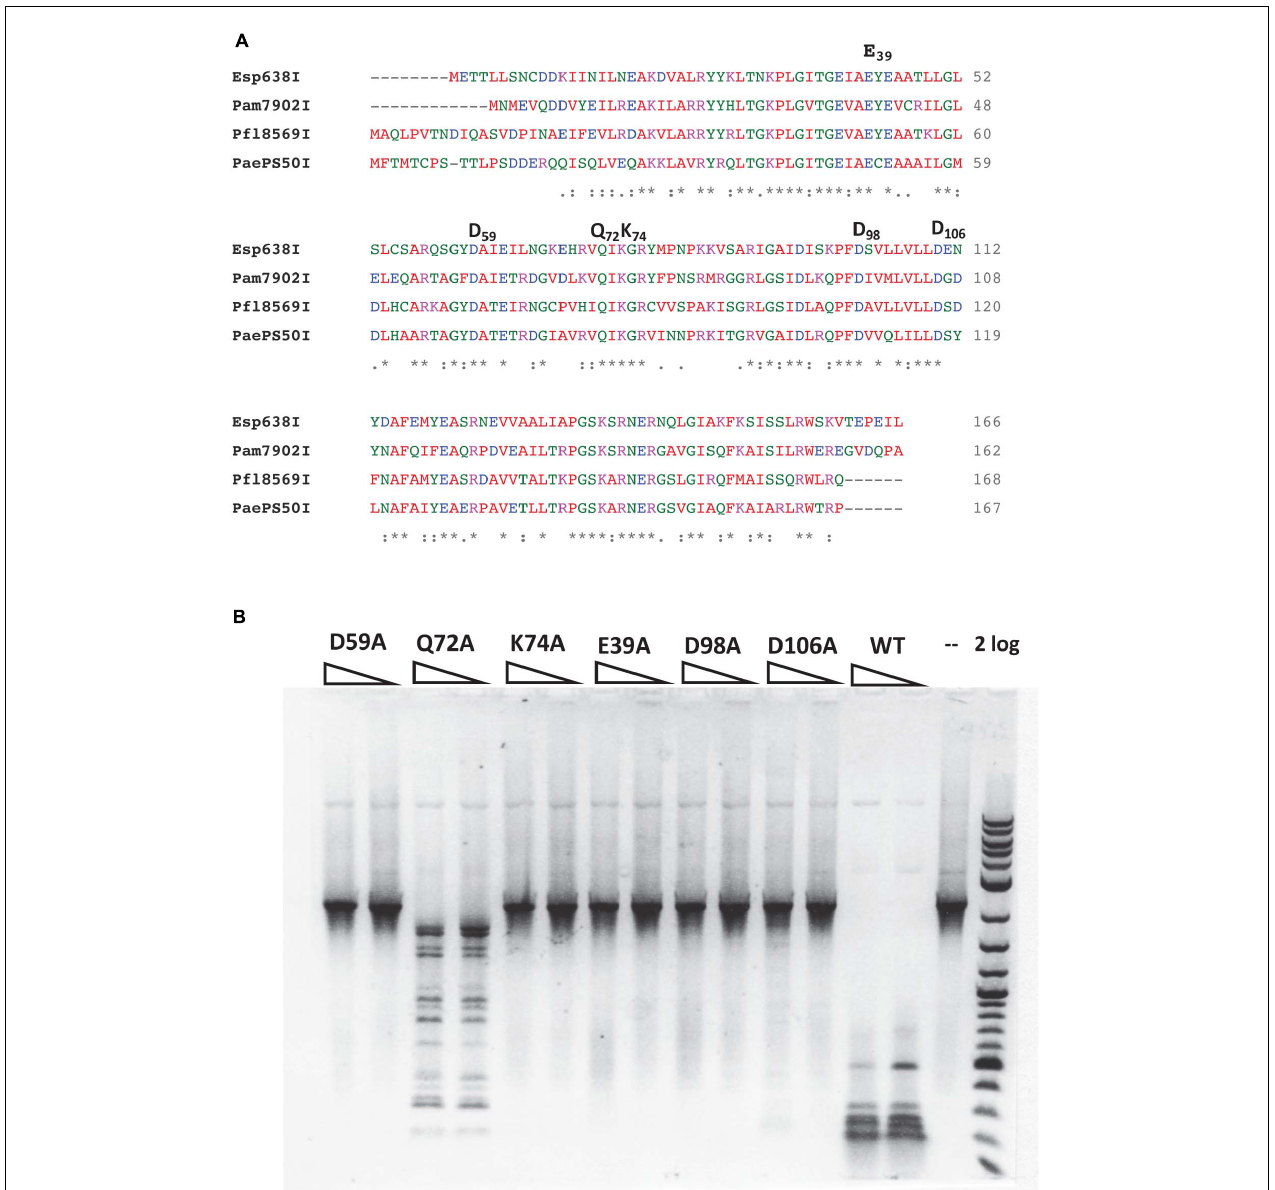
FIGURE 3 | Multiple sequence alignment of Esp638I, Pfl8569I, Pam7902I, and PaePS50I, predicted Mrr-like catalytic site, and activity assay for catalytic mutants. (A) Multiple aa sequence alignment by CLUSTAL O (1.2.4). “*”, identical aa residues. “:”, aa residues with similar biochemical property. (B) Restriction activity assay for Pam7902I catalytic mutants (two enzyme dilutions). The PCR DNA substrate (2.1 kb) contains modified cytosines-hm5C replacing all cytosines. 2 log, 2-log DNA ladder (0.1 to 10 kb,